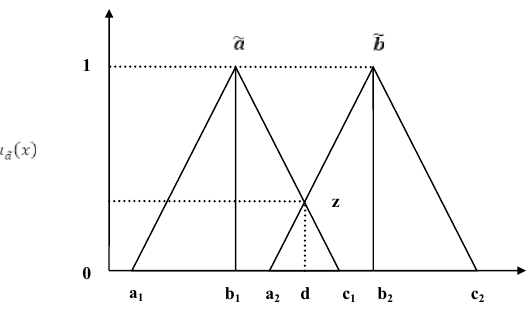
Fig. 2 The intersection